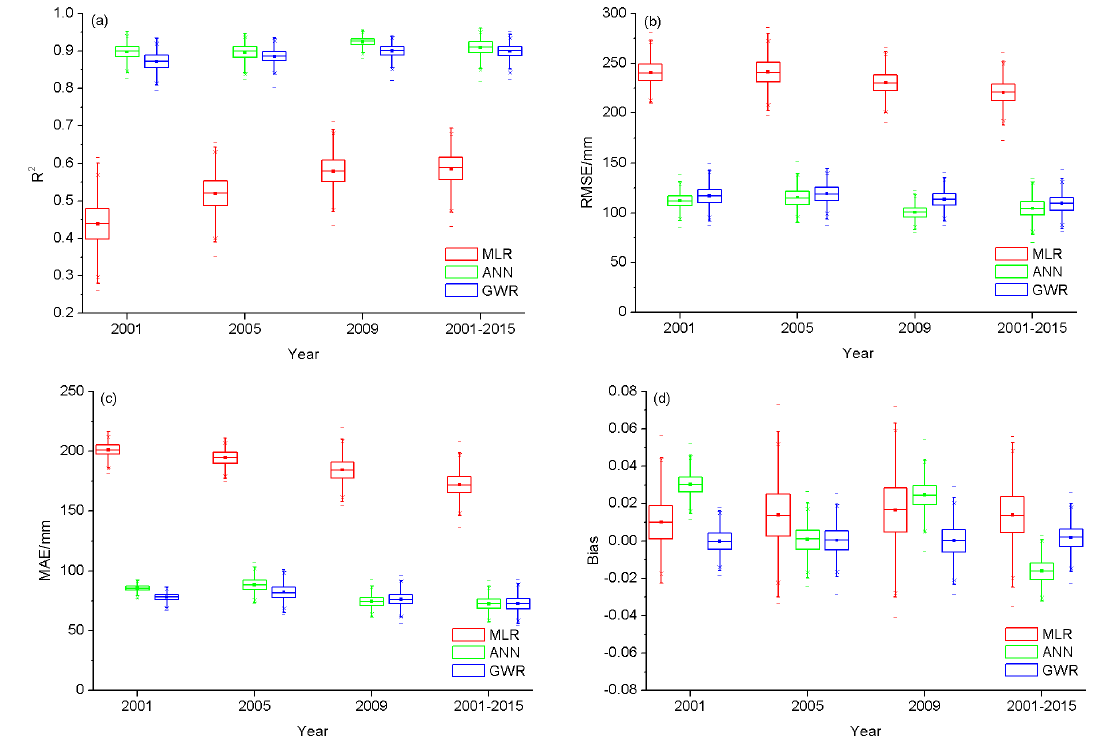
( c ) Figure 5. Comparison of precipitation measured by RGS with the original TRMM 3B43 data at multi- time scales: ( a ) the dry season; ( b ) the wet season; and ( c ) the whole year from 2001 to 2015. The red line indicates a 1:1 correspondence. 3.2. Performance of the Different Downscaling Models Obtaining the regression relationship between the TRMM precipitation and environmental variables, is a vital premise of the downscaling procedure, which directly affects the final result. Therefore, the predictive performances of three regression models (MLR, ANN, and GWR) were evaluated by comparing the predicted annual precipitation by each model with the original TRMM annual precipitation at 0.25° resolution. To better compare the performance of the three models, a bootstrapping procedure was employed to create a sample of the same size as the original data, a total of 1000 tests were conducted, and performance metrics (i.e., R 2 , RMSE , MAE , and Bias ) were calculated accordingly. Table 1 shows the mean values and 95% confidence interval of R 2 , RMSE , MAE , and Bias , estimated by the three models for the three reference years and entire time period. The box plots of R 2 , RMSE , MAE , and Bias are shown in Figure 6 . From Table 1 and Figure 6, it can be seen that both ANN and GWR produced a higher R 2 and lower RMSE and MAE than that of MLR under different climatic conditions. In terms of Bias , the Bias of GWR was lower than that of ANN in